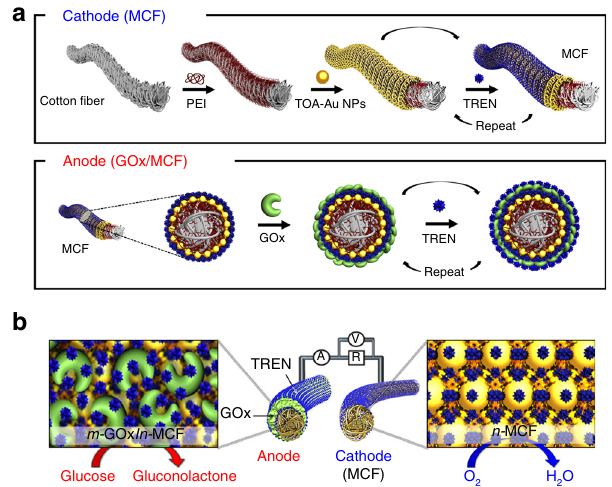
Fig. 1 Illustration of the metallic cotton fi ber electrode-based biofuel cell. a Preparation of the metallic cotton fi ber (MCF)-based cathode and the glucose oxidase (GOx)/MCF-based anode using small-molecule ligand- induced layer-by-layer assembly. At the fi rst stage, bare cotton fi ber was coated with poly(ethylenimine) (PEI, M w ~800). b Redox process for an MCF-biofuel cell (BFC) composed of a cathode and an anode. n -MCF: (tetraoctylammonium bromide-stabilized Au nanoparticle (TOA-Au NP)/ tris-(2-aminoethyl)amine (TREN)) n , m -GOx: GOx/tris-(2-aminoethyl) amine (TREN) m . The redox process of MCF-BFC, the resistance (R) of the applied external load and the location of voltage (V) and current (A) measuring devices. At the anode, glucose is oxidized to gluconolactone, where the electrons are transferred from the GOx to MCF. At the cathode, electrons are transferred from MCF through the electrolyte with oxygen reduction reaction